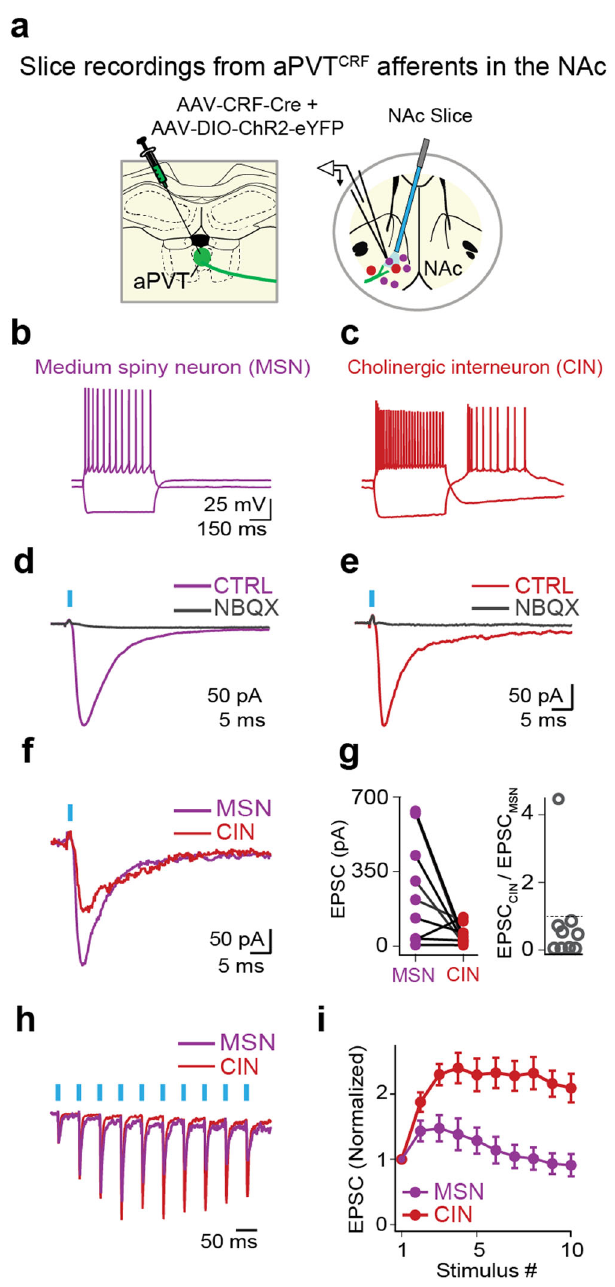
Fig. 8 aPVT CRF neurons mediate target-dependent synaptic transmission in the NAc in vitro. a Schematics showing viral injection site in aPVT and recording site in NAc in rat brain slices expressing ChR2-eYFP in aPVT CRF afferents. b , c Representative whole-cell recordings of a putative b medium spiny neuron (MSN, purple) and c cholinergic interneuron (CIN, red) showing responses to hyperpolarizing and depolarizing current steps ( − 300 and 200 pA, 500 ms). CINs were distinguished from MSNs by larger diameter cell bodies and rebound fi ring following a hyperpolarizing current step. d , e Representative examples of optically evoked excitatory postsynaptic currents in an d MSN and a e CIN prior to and following the application of the AMPA receptor antagonist NBQX. f Representative examples of optically evoked excitatory postsynaptic currents (EPSCs) in an MSN (purple) and a neighboring CIN (red) recorded sequentially (LED duration: 1 ms). g (Left) Summary data quantifying optically evoked EPSC amplitudes in sequentially recorded pairs of MSNs and CINs ( n = 9 pairs,